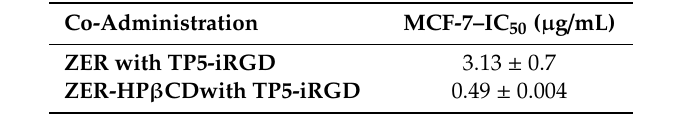
Table 3. The co-administration of ZER and ZER-HP β CD with TP5-iRGD peptide against MCF-7 cells after 72 h treatment. The co-administration of ZER or ZER-HP β CD with TP5-iRGD peptide at a ratio 1:10 in MCF-7 cells reduced the IC 50 of ZER from 7.51 ± 0.2 µ g / mL to 3.13 ± 0.7 µ g / mL and reduced the IC 50 of ZER-HP β CD from 5.08 ± 0.2 µ g / mL to 0.49 ± 0.004 µ g / mL after 72 h